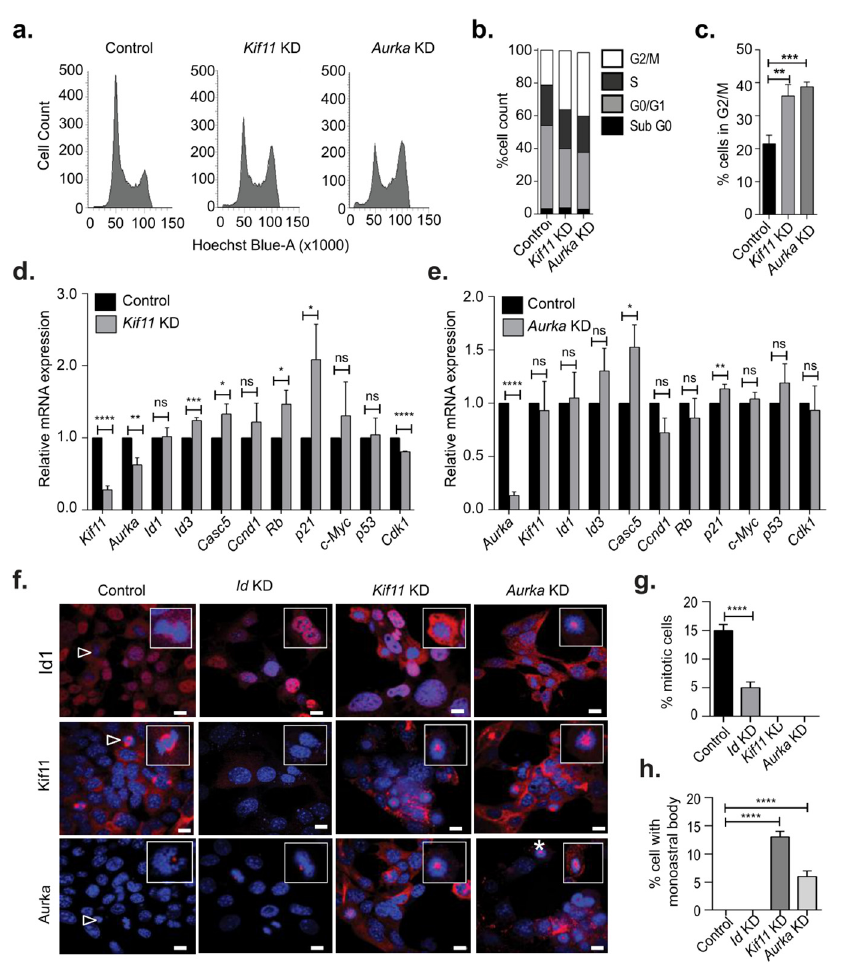
Figure 4. Kif11 and Aurka depletion did not phenocopy loss of Id1. ( a ) Flow cytometric analysis of cell cycle in Kif11 KD and Aurka KD with scrambled control in 4T1 cells. ( b ) Comparing the percentage cell count in each phase of the cell cycle after knocking down Kif11 and Aurka . ( c ) There were significantly higher cells in G2 / M phase Kif11 KD and Aurka KD when compared to control. ( d , e ) The relative mRNA expression level of important cell cycle gene were analyzed in Kif11 KD and Aurka KD with respect to scrambled control using qRT-PCR. Data were normalized to β -actin and analyzed by the 2 − ∆∆ Ct method. ( f ) Immunofluorescence staining for Id1, Kif11 , and Aurka on 4T1 control, Id KD, Kif11 KD, and Aurka KD cells. Representative images were taken using a Nicon A1R + confocal system at 100x magnification with a scale bar corresponding to 100um. 4 (cid:48) ,6-Diamidino-2-fenylindool (DAPI) shows the nuclear staining; asterisk (*) shows the monoastral bodies formation in siRNA KD system; ∆ shows normal cell division; and inset shows the 100 × zoomed images of the same images. ( g ) Percentage mitotic cells in control, Id KD, Kif11 KD, and Aurka KD cell lines. ( h ) Cells exhibiting monoastral body formation in control, Id KD, Kif11 KD, and Aurka KD conditions. All experiments were performed in three biological replicates and data were expressed as mean ± standard deviation. Unpaired Student’s t -test and two- way ANOVA were used. * p < 0.05, ** p < 0.01, *** p < 0.001, **** p < 0.0001, ns is non